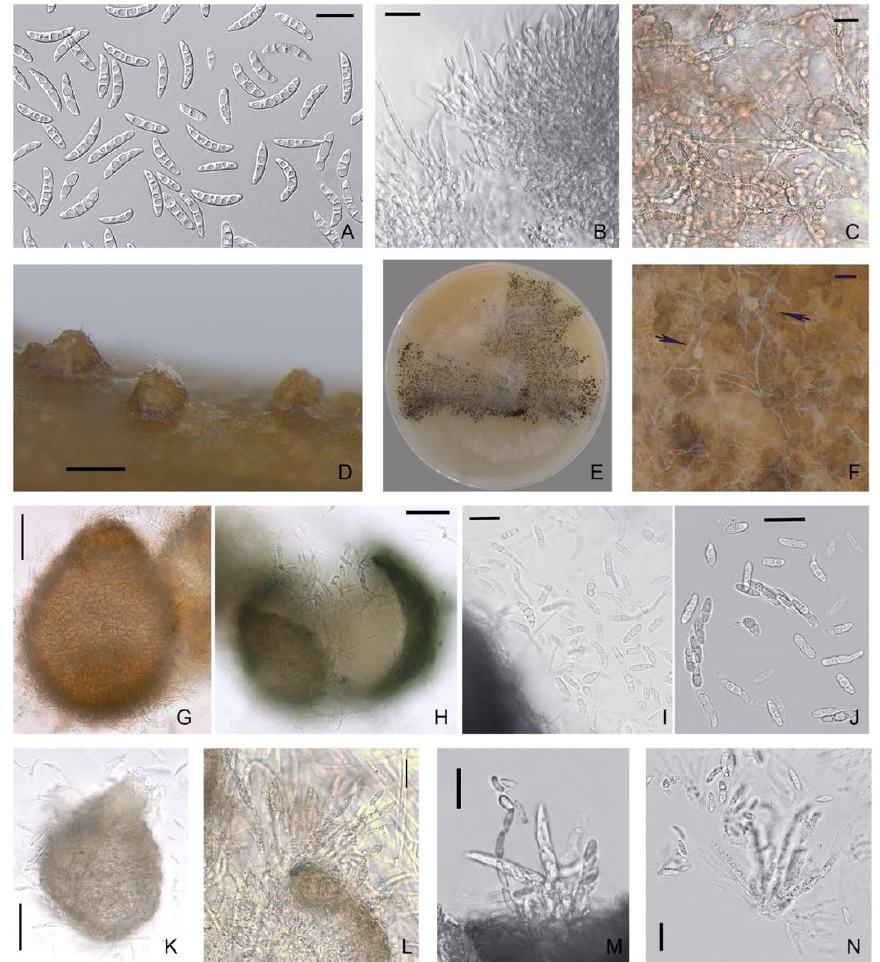
Figure 3. M. majus : ( A ) conidia; ( B ) aggregated conidiophores with conidiogenous cells; ( C ) dark brown hyphal cells; ( D , E ) ascomata; ( F ) ascogenous hyphae; ( G ) intact protoperithecium; ( H ) ascospores exuded from crashed perithecium; ( I , J ) ascospores; ( K ) ascospores exuded from the ostiole; ( L , M ) prototunicate asci with thickened annulus; and ( N ) asci, ascospores, paraphyses. Media: ( A – C , E – K ) PSA; (D , L – N ) wheat stems. Scale bars: ( A – C , I,J , L , M,N ) 20 μm; ( G,H,K ) 50 μm; ( D,F ) 100 μm.